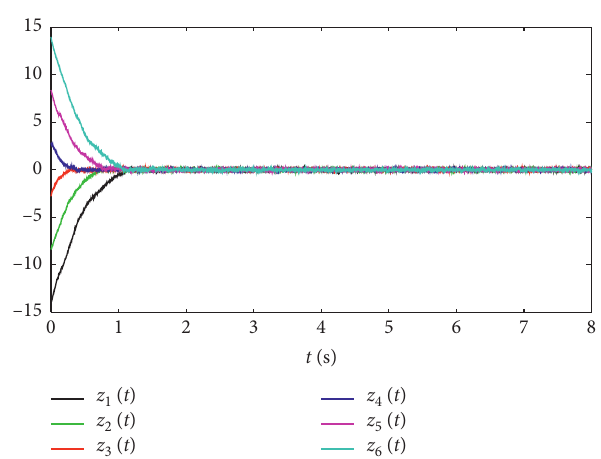
Figure 3: The state vectors z